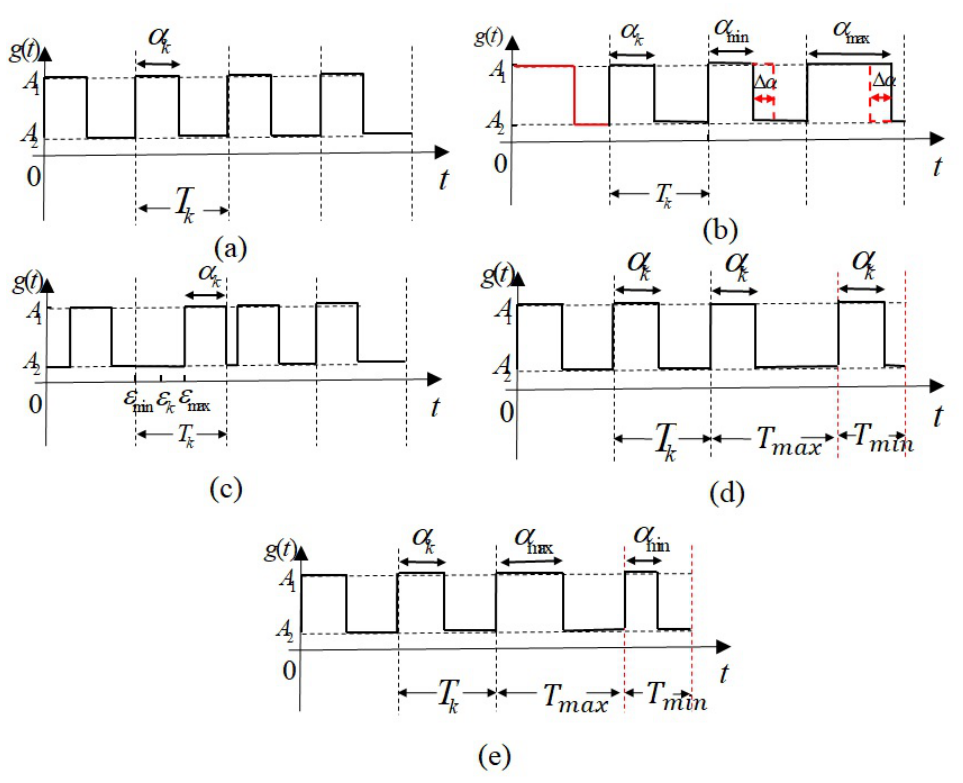
Figure 4. Typical pulse modulation random switching signals: ( a ) PWM, ( b ) RPWM, ( c ) RPPM, ( d ) RCFMVD, and ( e )